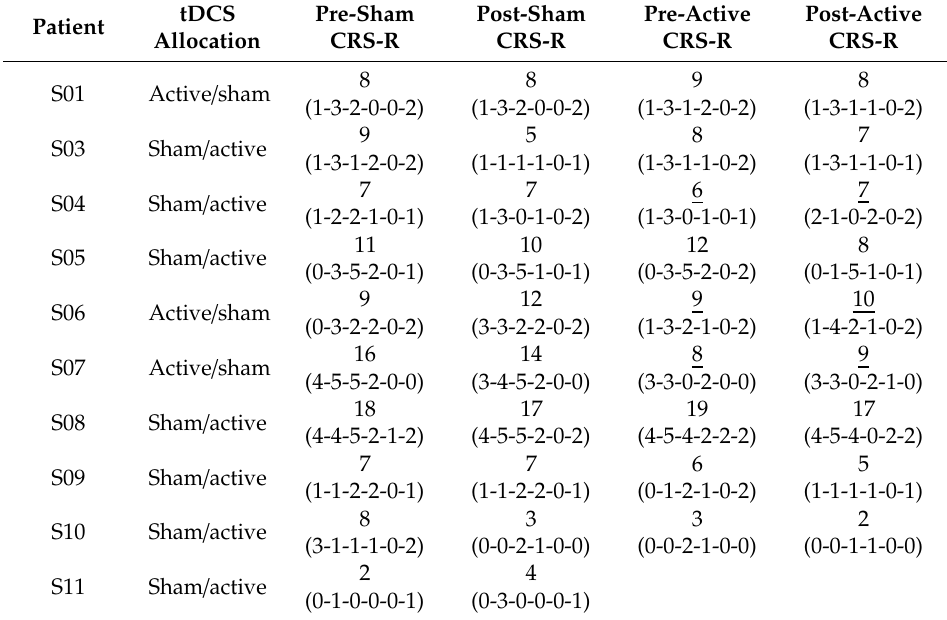
Table 2. Behavioral outcomes. Coma Recovery Scale—Revised totals and sub-scores for the pre- and post-sham and the pre- and post-active sessions of transcranial direct current stimulation. The CRS-R total scores in bold and underlined correspond to the total scores obtained by the three responders before and after active